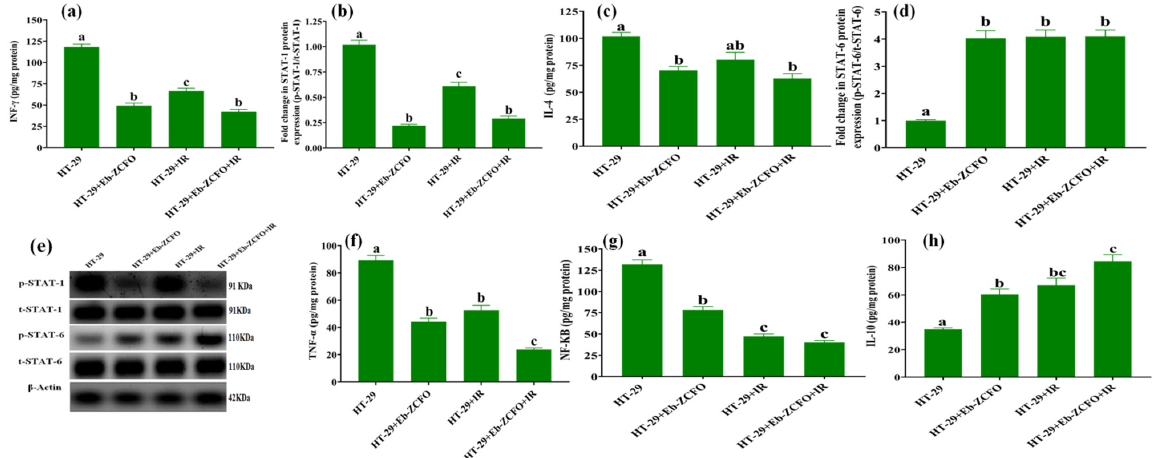
Figure 16. Inflammatory status and crosstalk of the signalling pathways TNF- α /NF- κ B, INF- γ /STAT-1, and IL-4/STAT-6 in HT-29 cells. Represented as follows: levels of ( a ) INF- γ , ( b ) protein expression of STAT-1, ( c ) IL-4, ( d ) protein expression of STAT-6, ( e ) representative western blot analysis, SDS-PAGE of STAT-1, STAT-6, and β - actin, ( f ) TNF- α , ( g ) NF- κ B, and ( h ) IL-10. Results are expressed as the mean and standard error of the mean (SEM) (n = 3). Columns with dissimilar letters (a, b, c…) overhead within the same histogram are significantly different, and columns with the same letters are not significantly different at p < 0.05. HT-29 group: untreated HT-29 cells line served as control, HT-29 + Eb-ZCFO group: HT-29 cells line treated with Ebselen (Eb) and ZnCe 0.06 Fe 1.94 O 4 nanoparticles (ZCFO), HT-29 + IR group: HT-29 cells exposed to γ -radiation, and HT-29 + Eb-ZCFO + IR group: HT-29 cells treated with Eb-ZCFO and exposed to IR.